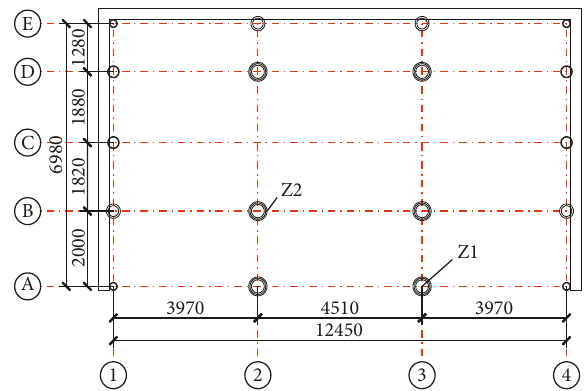
Figure 4: Plane graph of Liben hall (mm).